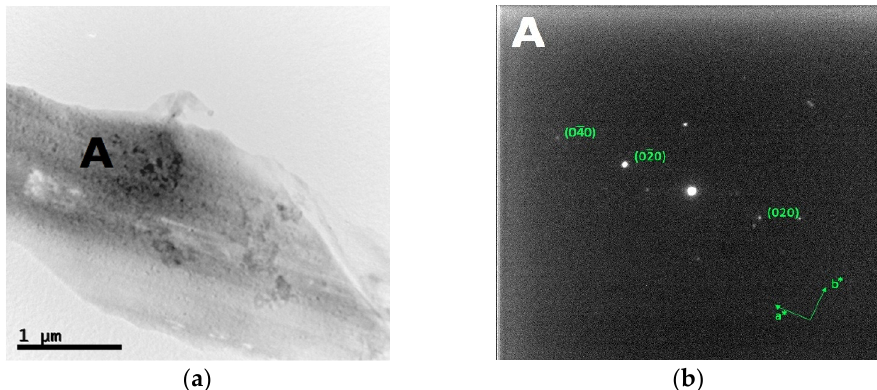
Figure 10. Bright field TEM images ( a ) and the corresponding SAED pattern ( b ) of the inter-dendritic phase in the CoCrFeMnNiZr alloy after recrystallization.